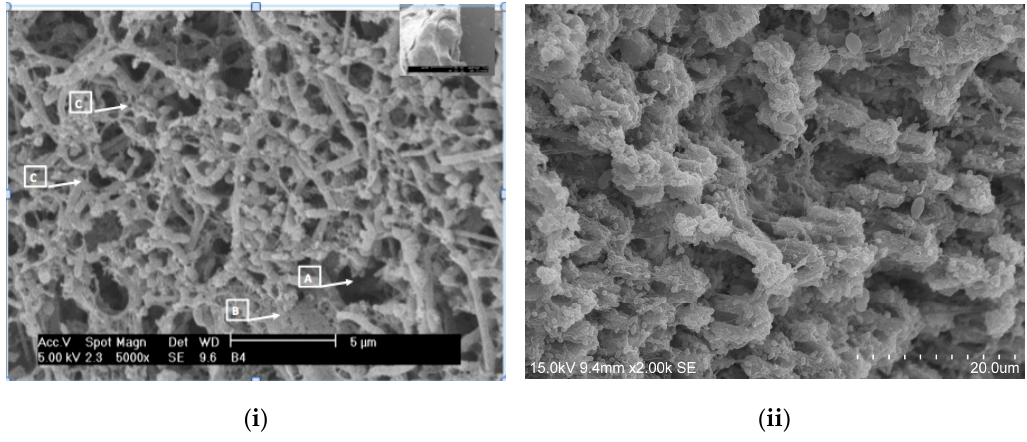
Figure 2. Scanning electron microscopic images of ( i ) Clostridium botulinum and Streptococcus anginosus (5000×). Communication channels inside the biofilm (A), fusion of extracellular fibers in laminar shape (B) and the presence of numerous polymeric fibers secreted by rods and cocci forming a crisscross pattern (C) are evident. (Courtesy: Dr. Ana Maria González Amaro, Maria Verónica Méndez González, UASLP Mexico); ( ii ) 3 weeks biofilm of Enterococcus fecalis on dentin (2000×). The dense EPS matrix is visible and the challenge in eradicating biofilms of this microbe is, in part, attributed to the ability of medicaments to penetrate this matrix. This is the most commonly implicated bacterium in root canal treatment failure.